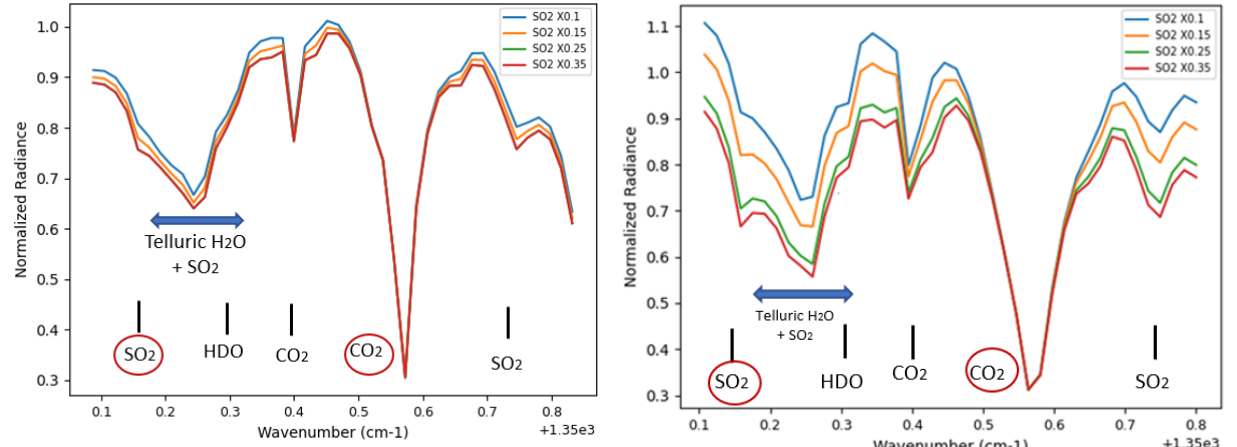
Figure 8. Effect of the variation of SO 2 abundance on the resulting radiance—ldr method on Venus. Small variations of the abundance of SO 2 were used since the depth of the corresponding lines are sensitive to small variations. ( Left panel ) VIRA-2 model. Four different abundances of SO 2 were used, represented by a different scaling factor (for example, SO 2 = × 0.1 corresponds to a model where the standard abundance of SO 2 in VIRA-2 was multiplied by 0.1). The red circles highlight the SO 2 and CO 2 lines used to calculate the line depth ratio. The ldr(SO 2 /CO 2 ) scales linearly with the abundance of SO 2 . ( Right panel ) LMD-VGCM model. Four different abundances of SO 2 were used. The ldr(SO 2 /CO 2 ) scales linearly with the abundance of SO 2 . The error of the simulations is approximately